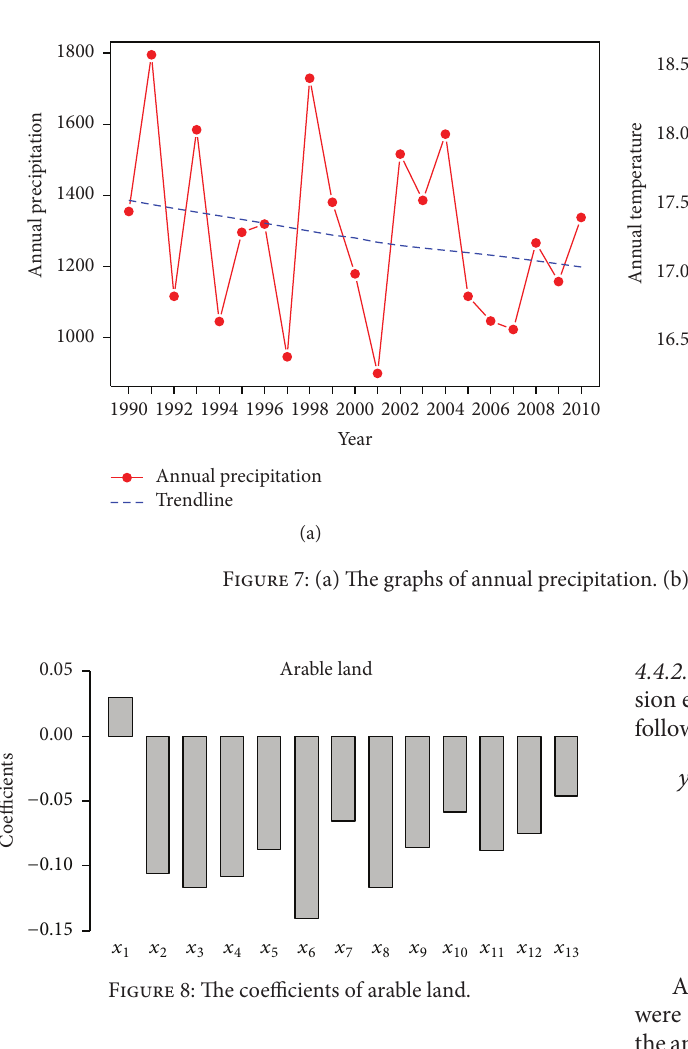
Figure 8: The coefficients of arable